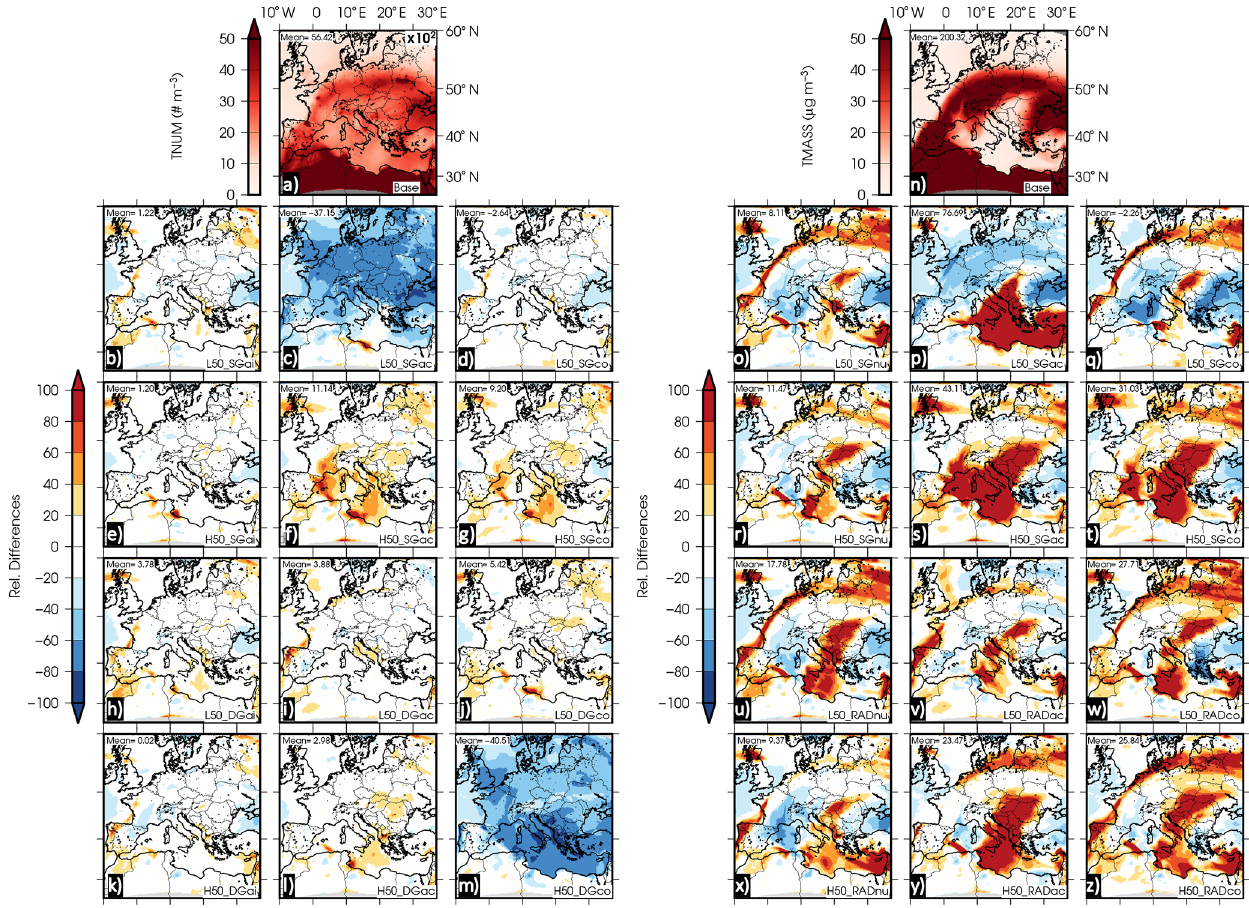
Figure 6. Same as Fig. 5 but for total mass concentration. Accumulation mode: (a) base case; (b) Aitken-mode 50% reduction in SG; (c) accumulation-mode 50% reduction in SG; (d) coarse-mode 50% reduction in SG; (e) Aitken-mode 50% increase in SG; (f) accumulation- mode 50% increase in SG; (g) coarse-mode 50% increase in SG; (h) Aitken-mode 50% reduction in DG; (i) accumulation-mode 50% reduction in DG; (j) coarse-mode 50% reduction in DG; (k) Aitken-mode 50% increase in DG; (l) accumulation-mode 50% increase in DG; (m) coarse-mode 50% increase in DG. (n–z) The same for the coarse